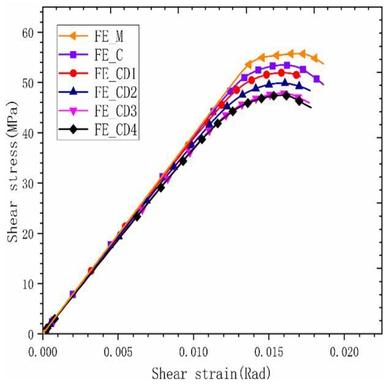
Shear stress-shear strain curve of FEA model.